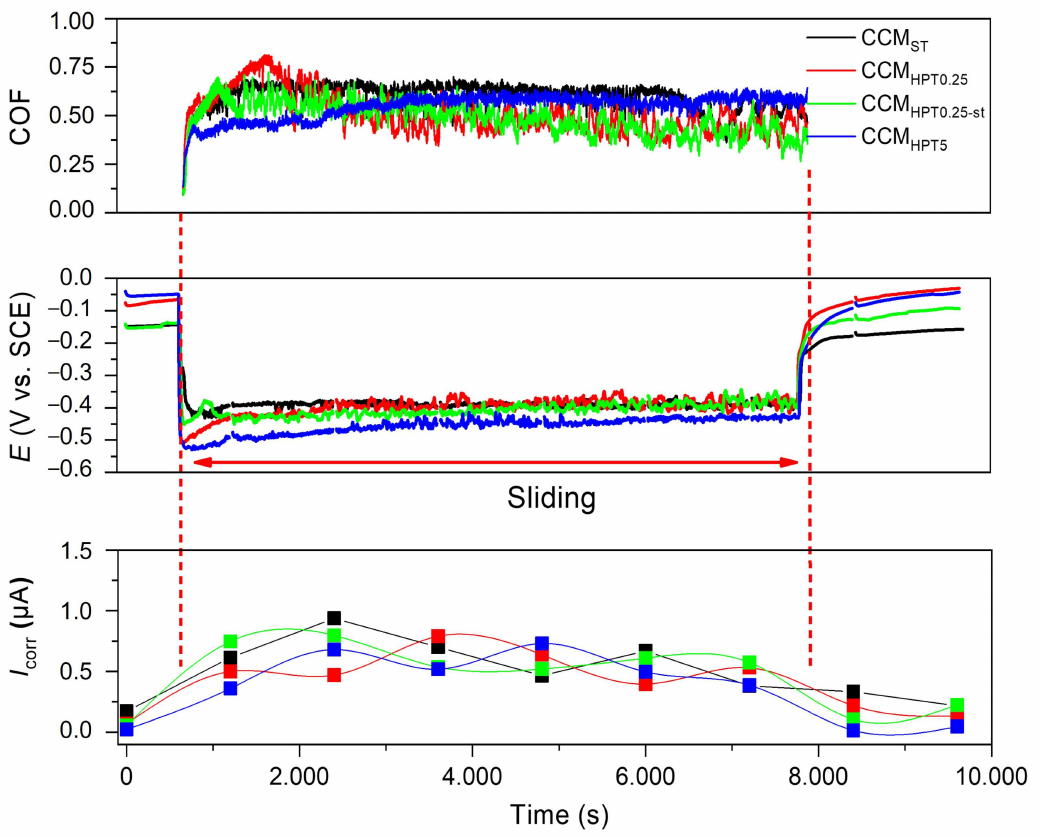
Figure 9. Evolution of OCP and I corr before, during, and after sliding, together with the evolution of COF during sliding for CCM